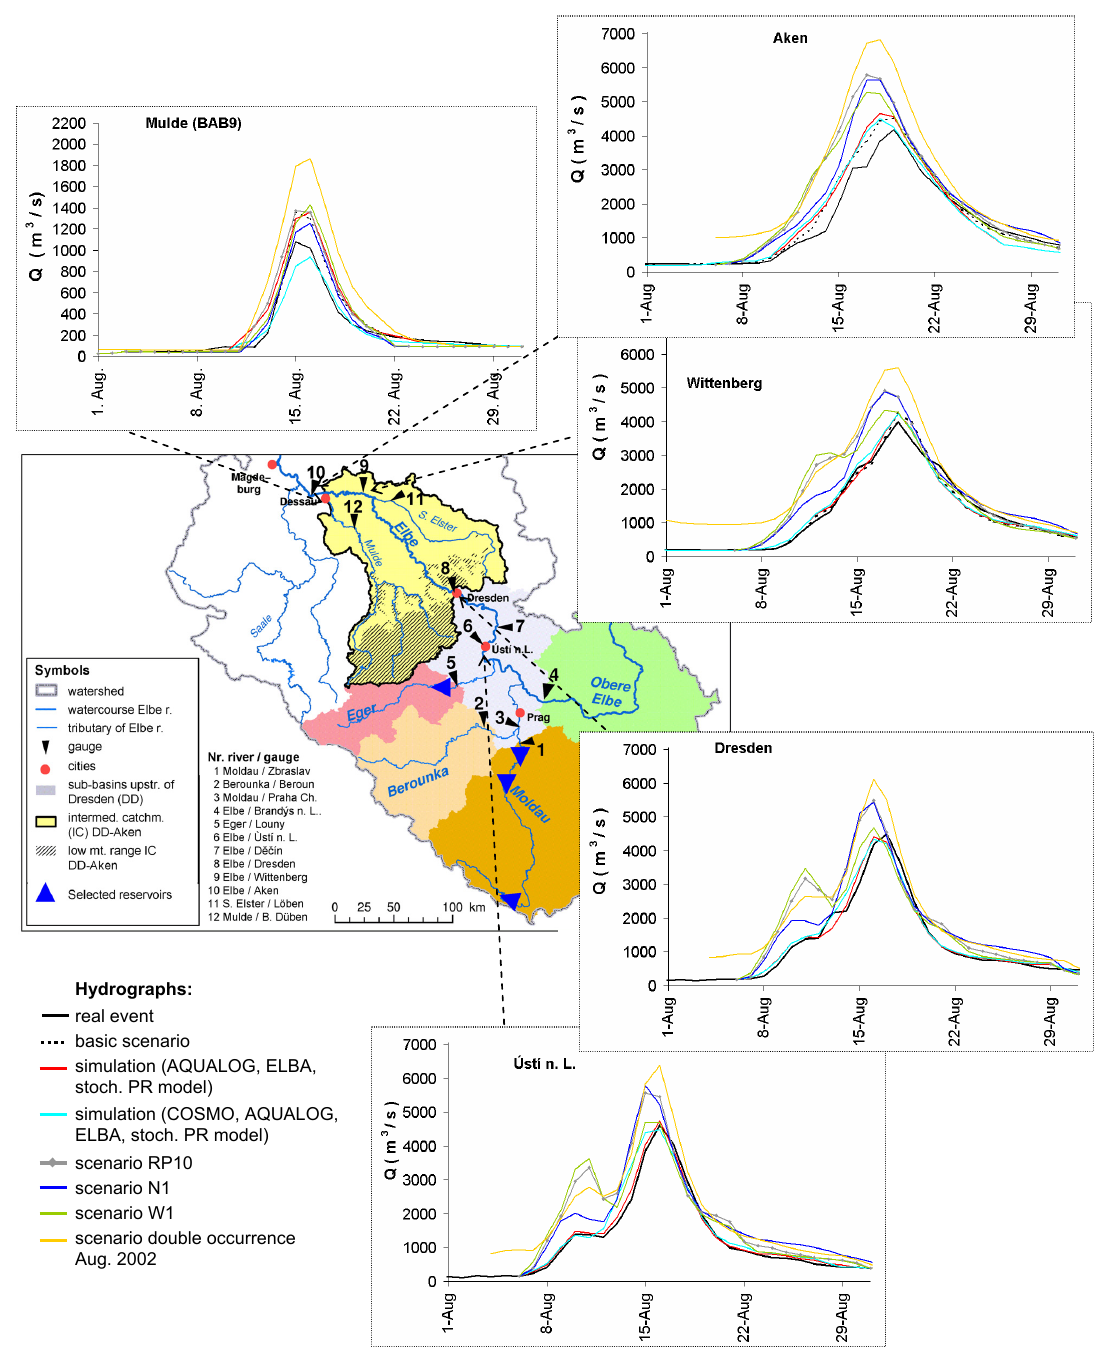
Fig. 3. Observed and simulated flood event of August 2002 in the Elbe basin upstream of Dessau. Compared to the real event, various scenarios show a considerable spectrum of possible event characteristics and thus the need of flexible strategies in operational flood manage-